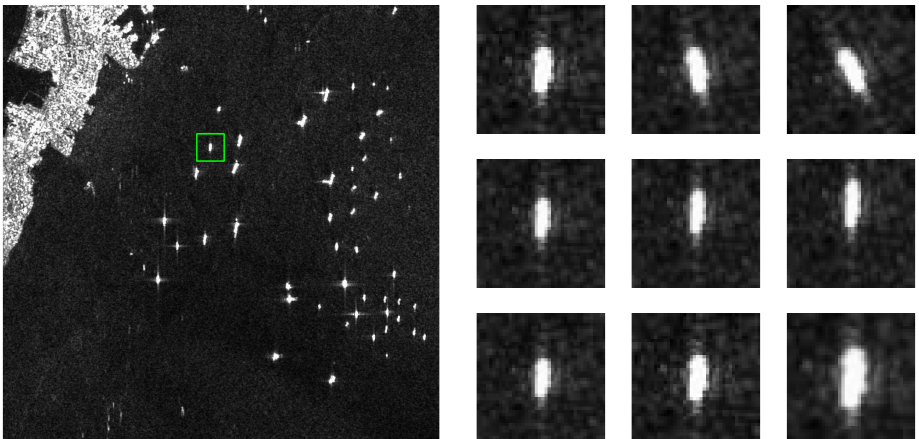
Figure 15. Some samples from AIR-SARShip-1.0 dataset. A large-scale SAR image indexed as 05_8_21 in AIR-SARShip-1.0 ( left ). A slice of one ship (marked by a green box in left subfigure) with three properties manually manipulated ( right